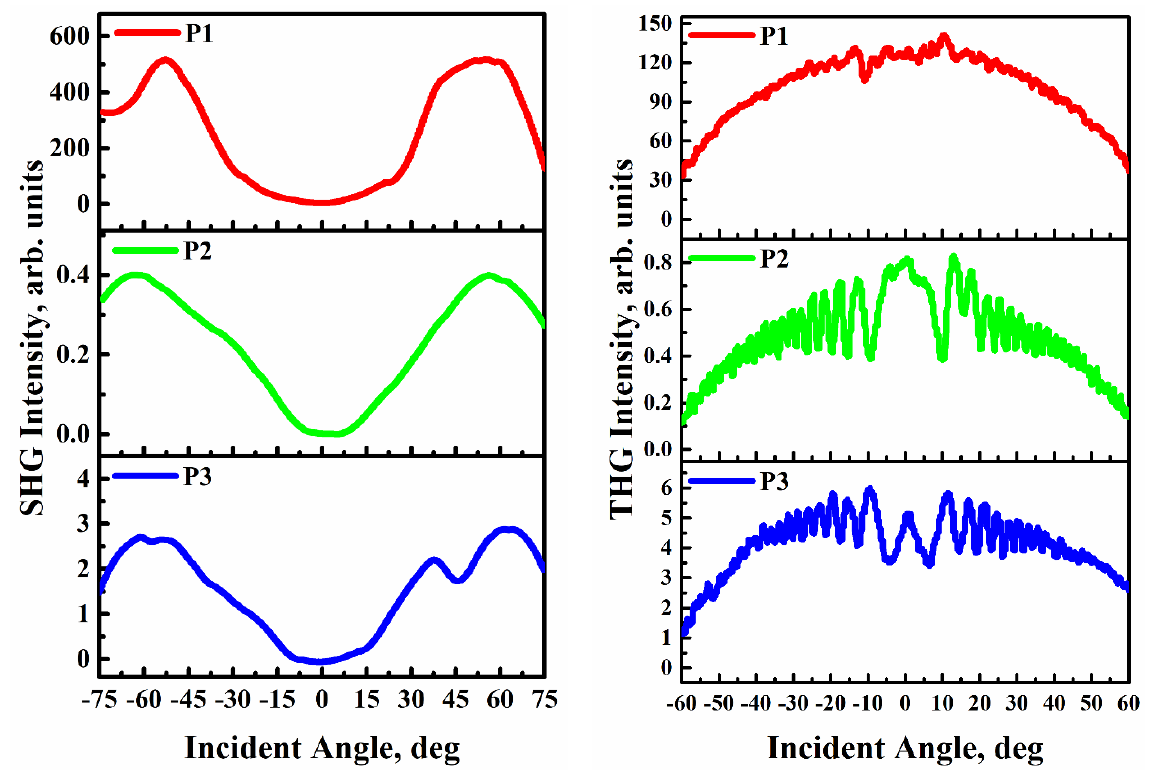
Figure 4. SHG and THG responses as a function of incident angle in P1 , P2 and P3 thin films with P − polarized (SHG) and S − polarized (THG) laser beams.